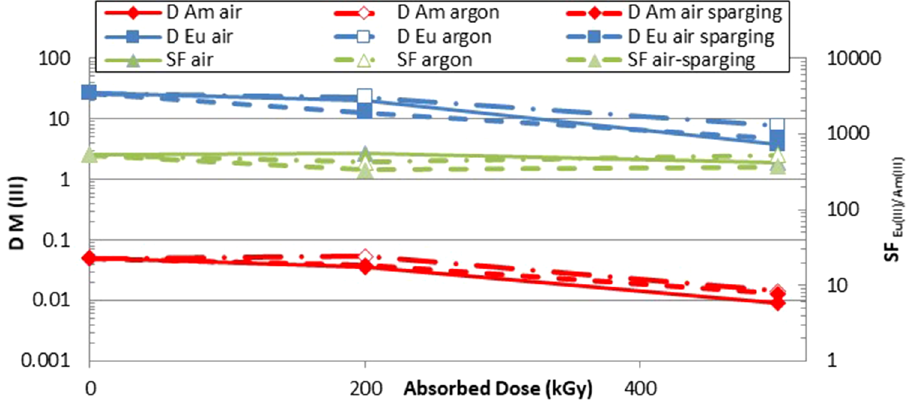
Fig. 1. Distribution ratios of Am(III) and Eu(III) as function of dose and the different irradiation conditions of the organic phase: air, Argon and air sparging. Organic phases: fresh or irradiated 0.2 mol/L TODGA in OK. Aqueous phases: fresh 18 mmol SO 3 -Ph- BTP in 0.5 mol/L HNO 3 . Spiked with 241 Am(III) and 152 Eu(III) (1 kBq/mL each).